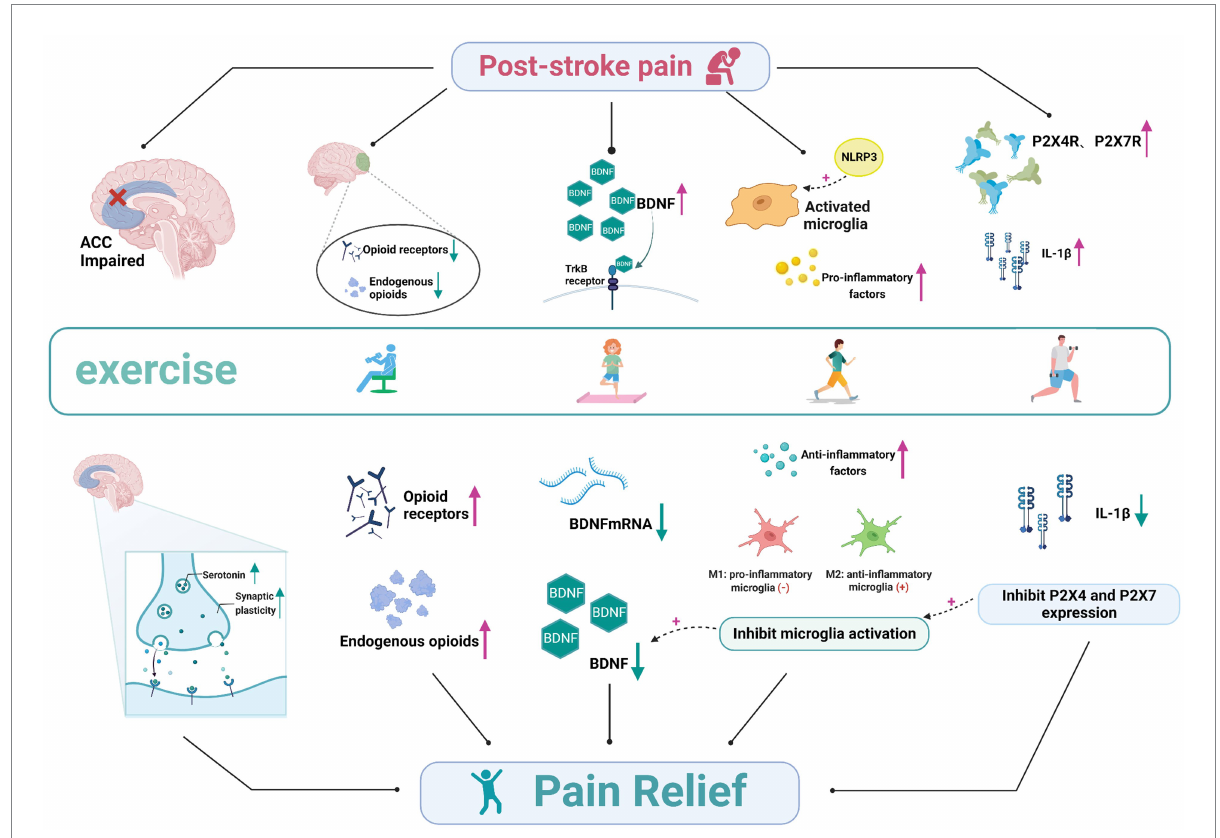
FIGURE 1 The involved mechanisms in exercise on post-stroke pain. The analgesic mechanism of exercise for post-stroke pain, involving the regulation of the synaptic plasticity in the anterior cingulate cortex regulation of endogenous opioids in vivo , reversal of brain-derived neurotrophic factor overexpression, inhibition of purinergic receptor (P2X4R, P2X7R) expression, and inhibition of microglia activation. ACC, anterior cingulate cortex; TrkB, tyrosine receptor kinase B; NLRP3, the Nod-like receptor family pyrin domain containing 3 (NLRP3); IL-1 β , interleukin-1 β